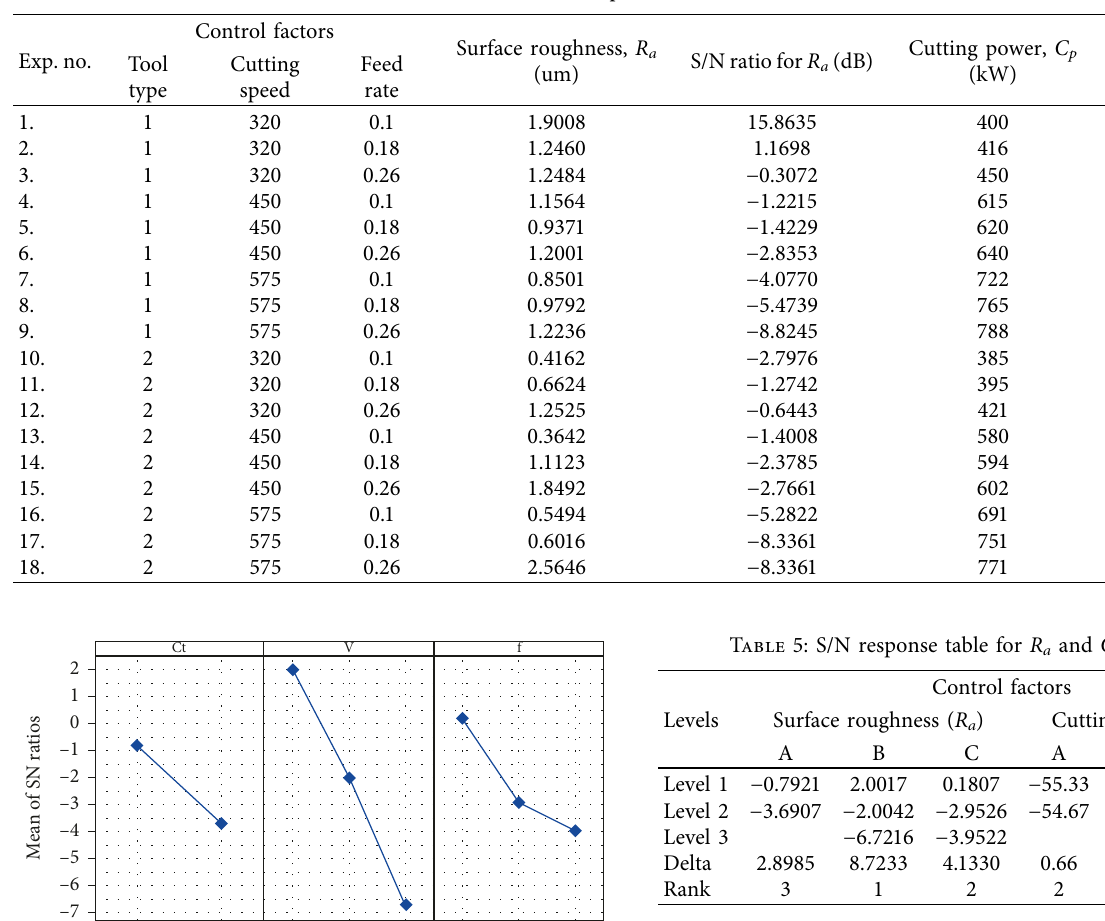
Table 4: The results of experiments and S/N ratio values.